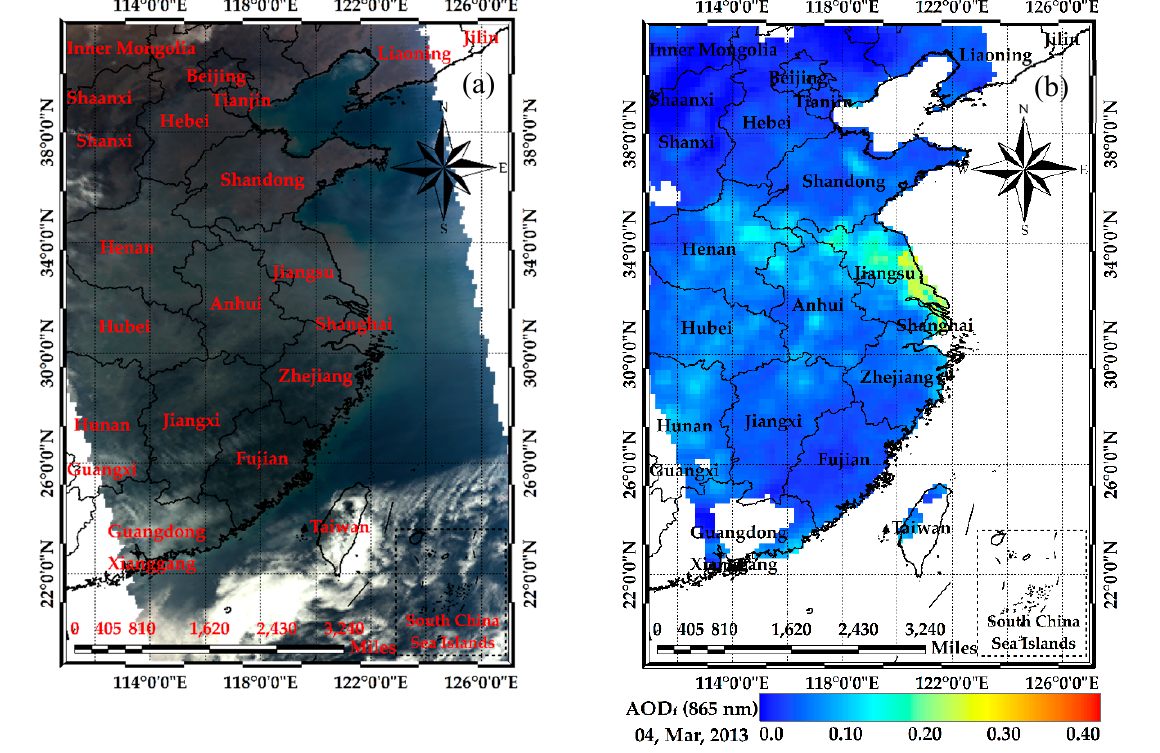
Figure 5. Same as figure 3 but for 4 March 2013.